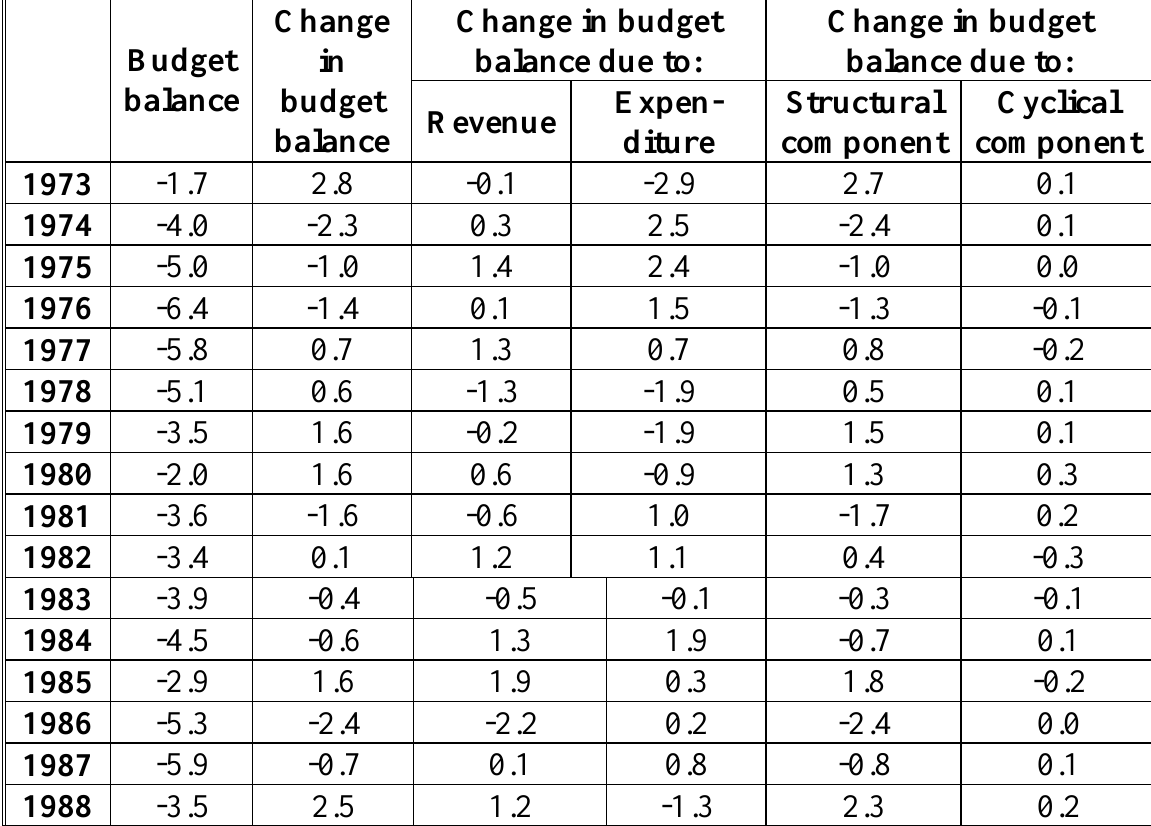
Budgetary developments, percentage of GDP Change in budget balance due